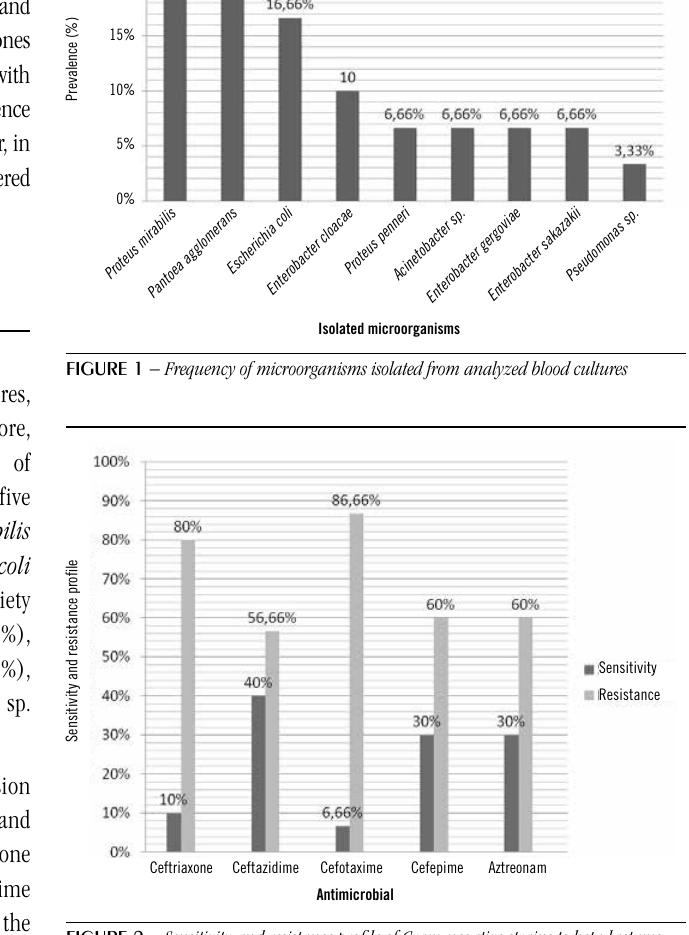
figurE 2 − Sensitivity and resistance profile of Gram-negative strains to beta-lactams